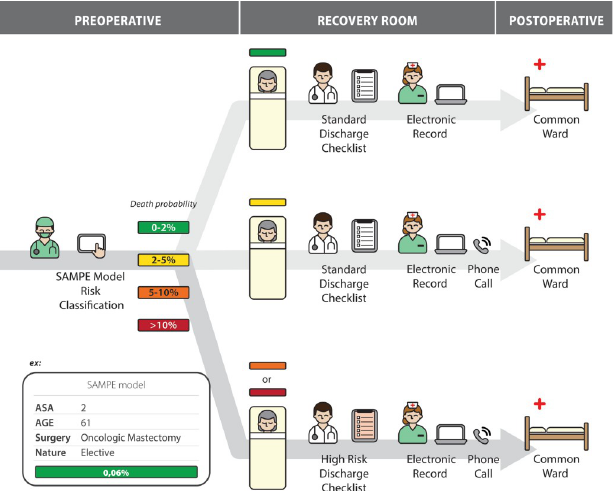
Fig 1. Schematic representation of the care flow of surgical patients after implementation of the SAMPE Model.